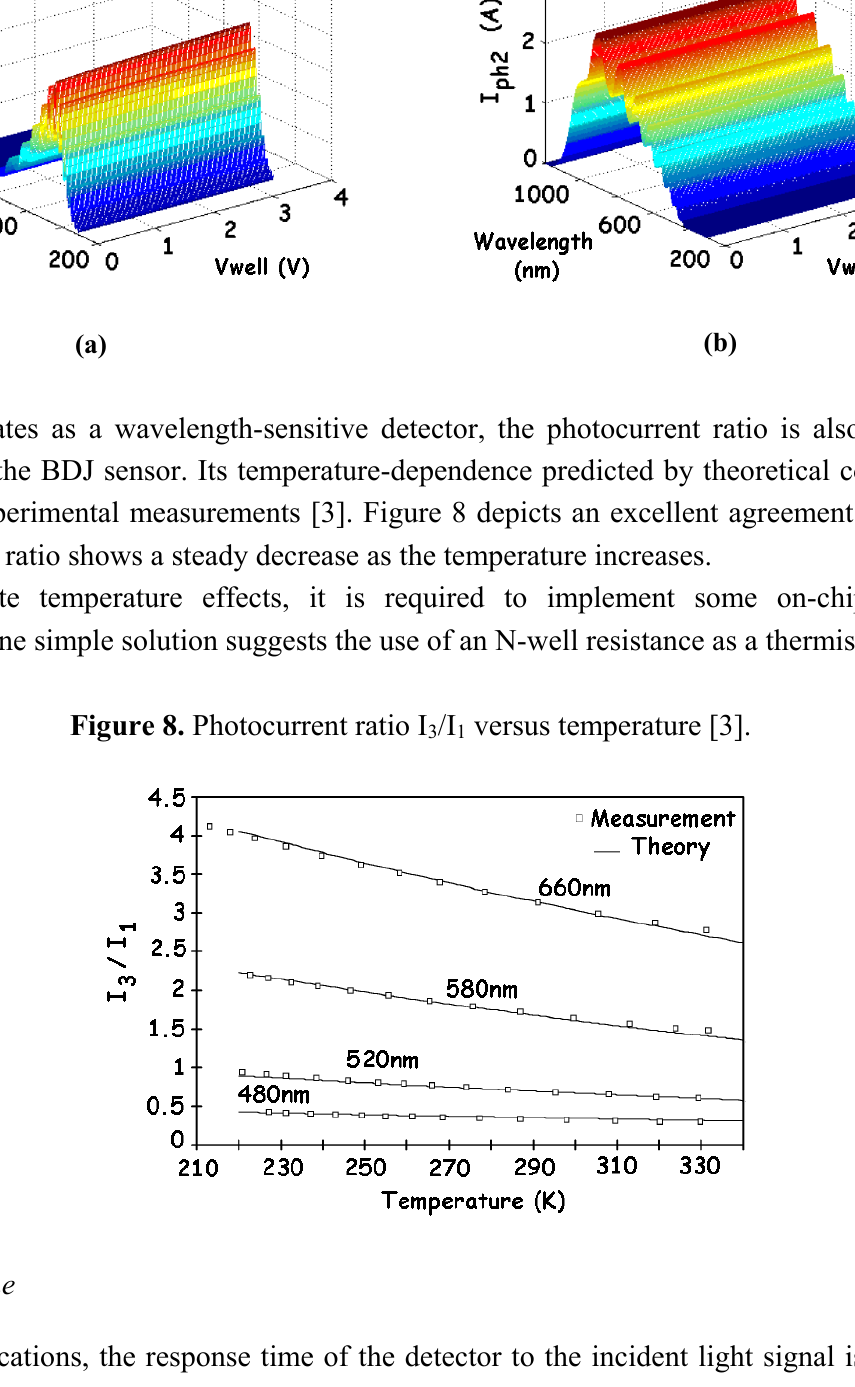
: (a) Photocurrent of the 2 . 2